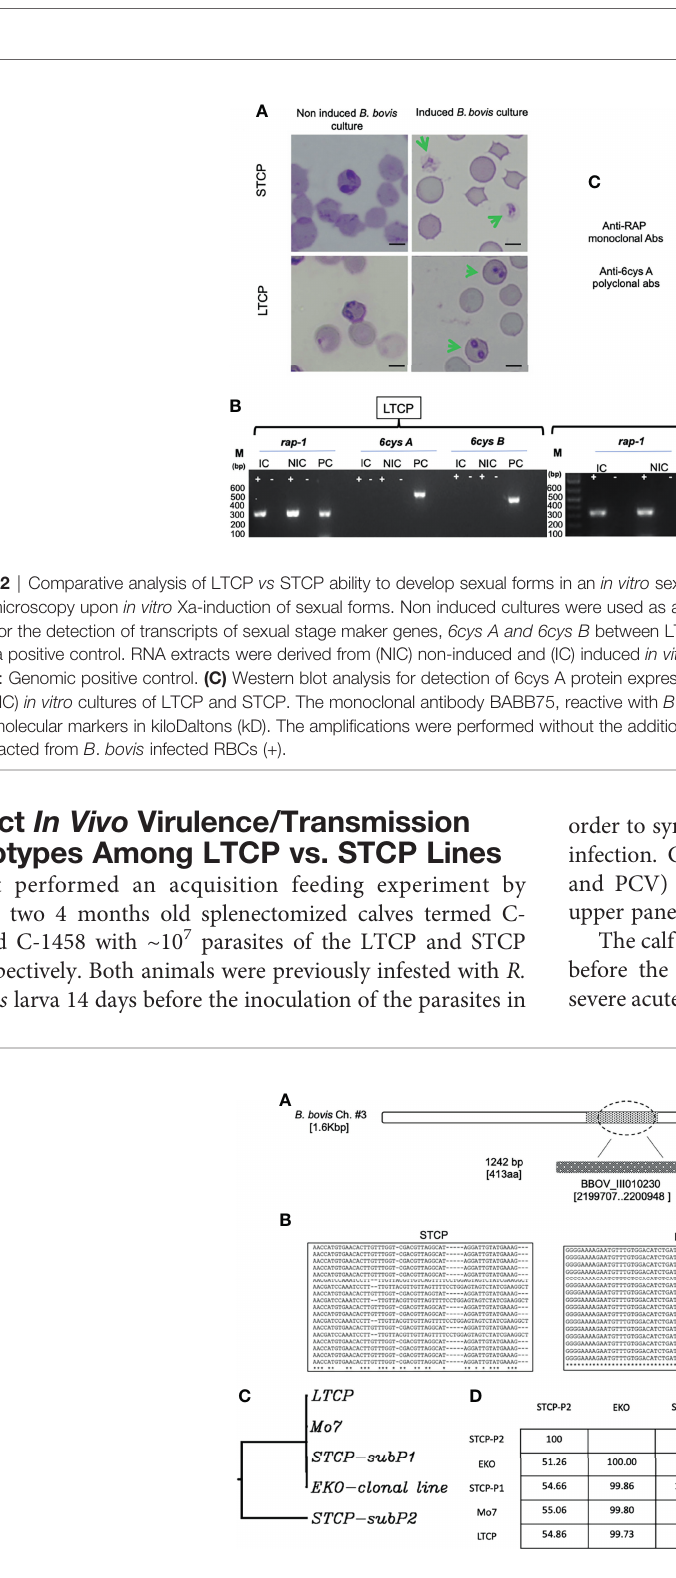
FIGURE 3 | (A) Illustration of the location of the gene BBOV_III10230 used for the detection of DNA polymorphisms, gene diversity, and phylogenetic analysis among different B. bovis strains. (B) Nucleotide sequence representations of PCR amplicons derived from STCP and LTCP. (C) Phylogenetic comparison between the STCP (2 distinct genes ampli fi ed by PCR: subP1 and subP2), LTCP, MO7 and EKO clonal lines. (D) The Table shows identity percent comparison for the ampli fi ed genomic area among the different investigated parasite strains.